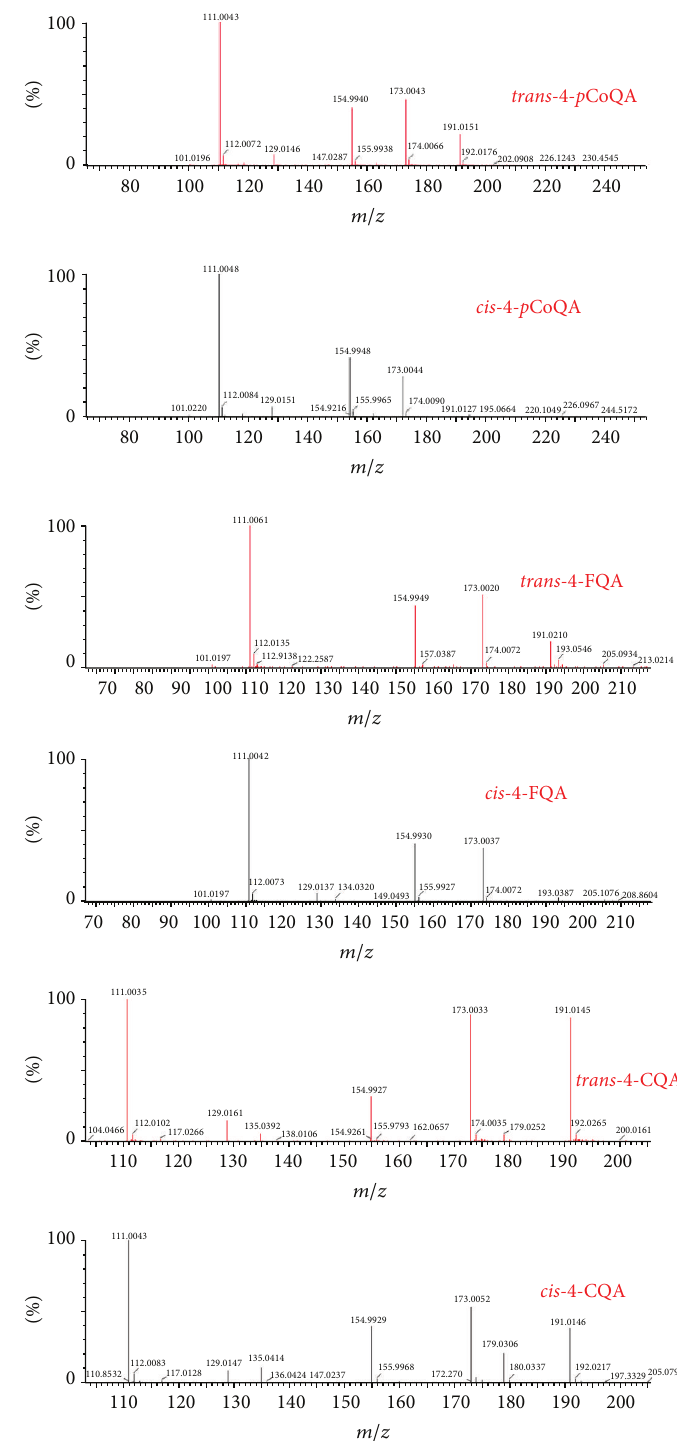
Figure 4: Representative mass spectra showing the major fragmentation differences at m/z 191 noted between trans and cis isomers of all CGA detected in Momordica species. The exact mass of m/z 191 and its proposed elemental formula are indicated in Table